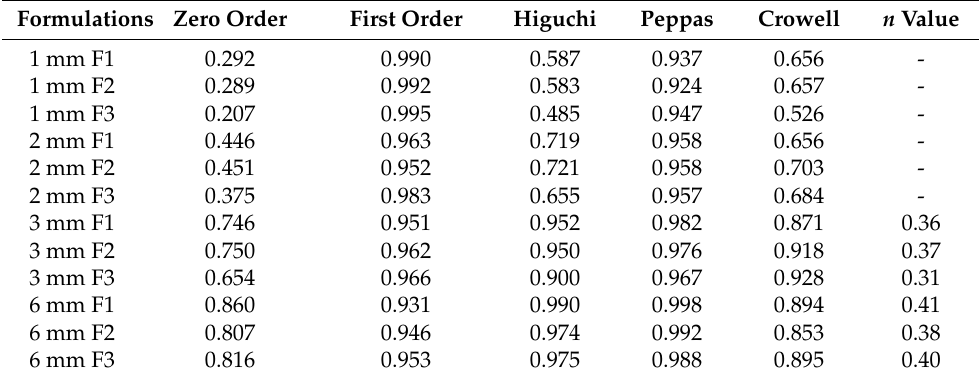
Table 4. Kinetic models of different drug release from different sized pellets.